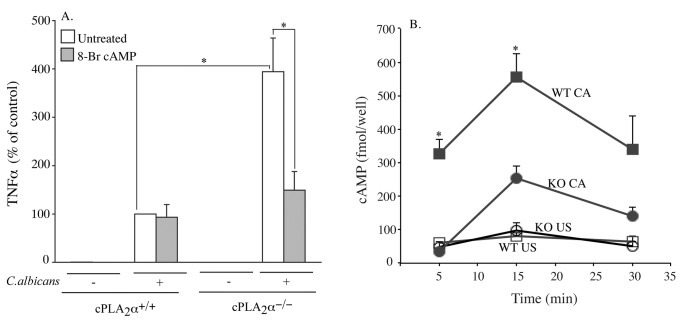
cAMP production is enhanced by cPLA2α activation and
suppresses TNFα production.(A) cPLA2α+/+ and cPLA2α-/-
RPM were incubated with 8-Br-cAMP (1 mM) for 30 min followed by
incubation with C.
albicans for 6 h. Levels of TNFα in the
culture medium were determined by ELISA. (B)
cPLA2α+/+ (WT, squares) and
cPLA2α-/- RPM (KO, circles) were incubated
with (closed symbols) or without (open symbols) C.
albicans (CA) for the indicated times. Cell
lysates were processed for cAMP determinations as described in
Experimental Design. The data are the average of 3 experiments ±S.E.
(*p<0.05). In panel B, CA treated WT vs. CA treated KO at 5 and 15
min are compared for significance.